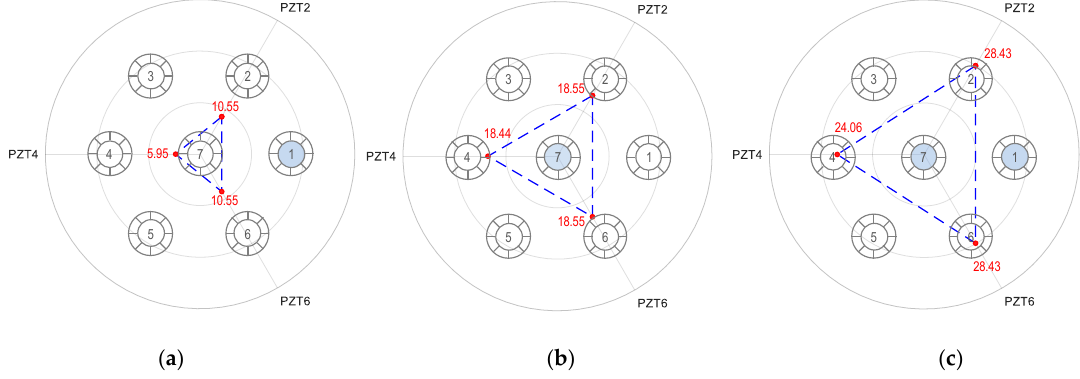
Figure 18. Linear tomography of RMSD indices (%) using PZTs 2, 4 and 6: Peak 1’s impedance . ( a ) Strand 1 breakage, ( b ) Strand 7 breakage, and ( c ) Strands 1 and 7 breakage.